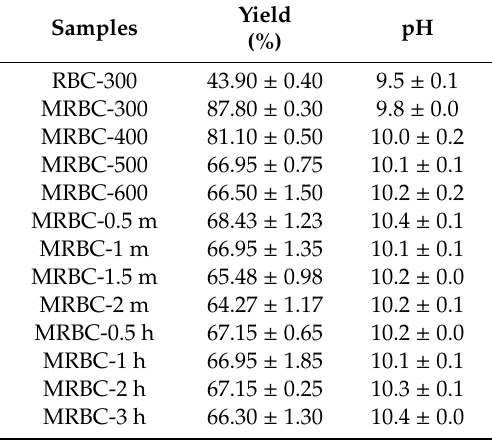
Table 2. Yield and pH of rice straw biochar (RBC) and MgO-modified biochars